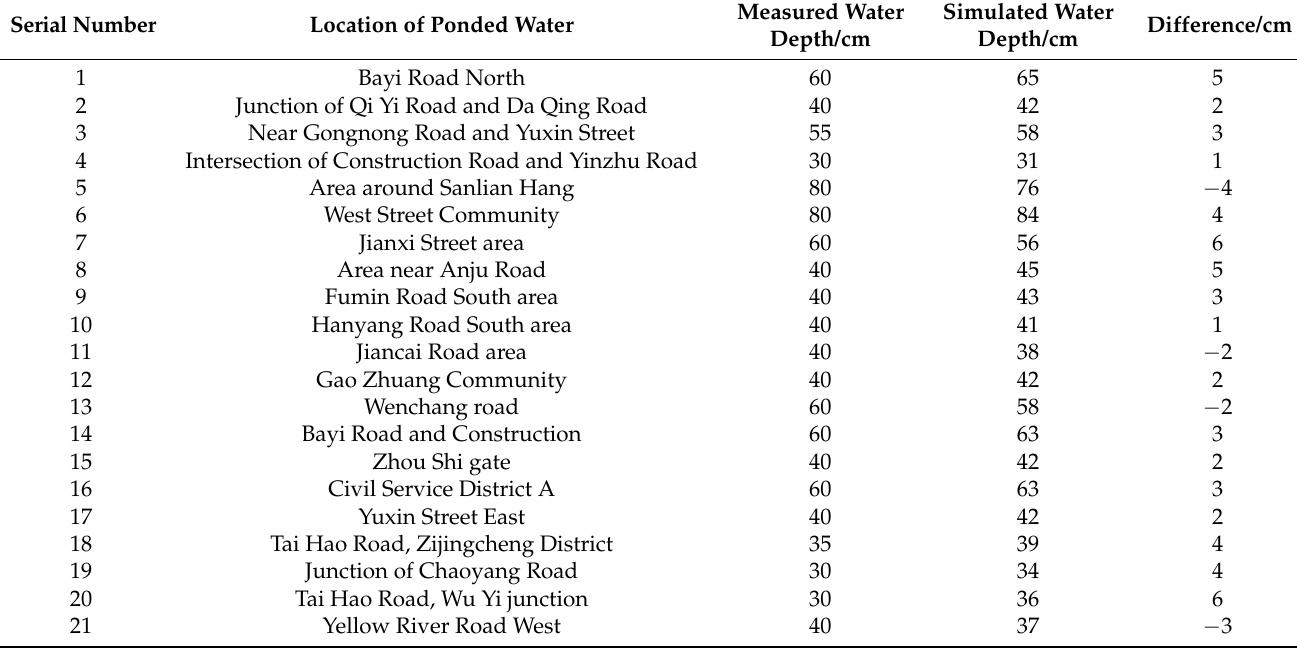
Table 2. Comparison of measured and numerically modeled ponding depths at inundated water points on 20 July